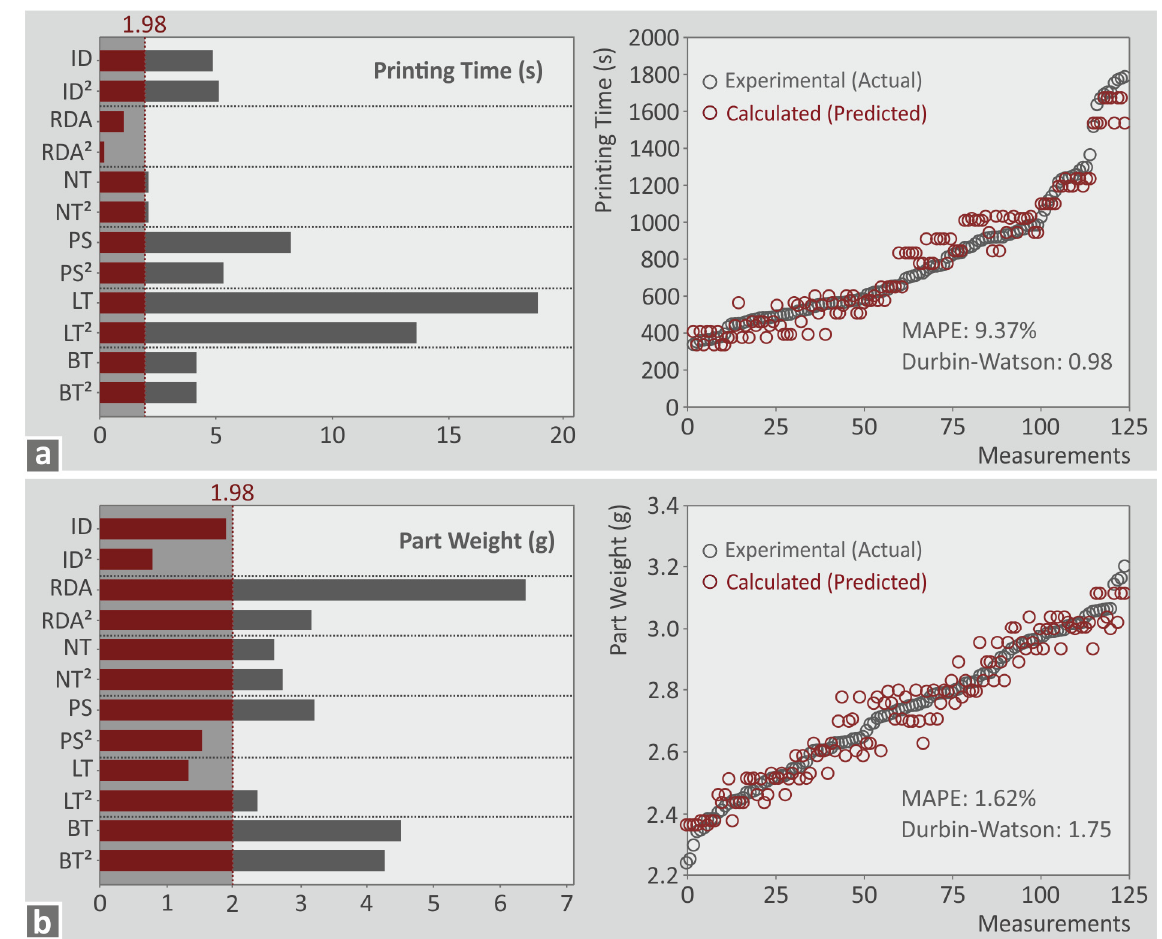
Figure 10. Pareto diagram along with a graph depicting a comparison between the experimental and the calculated values of the following metrics: ( a ) printing time (s), ( b ) part weight (g).